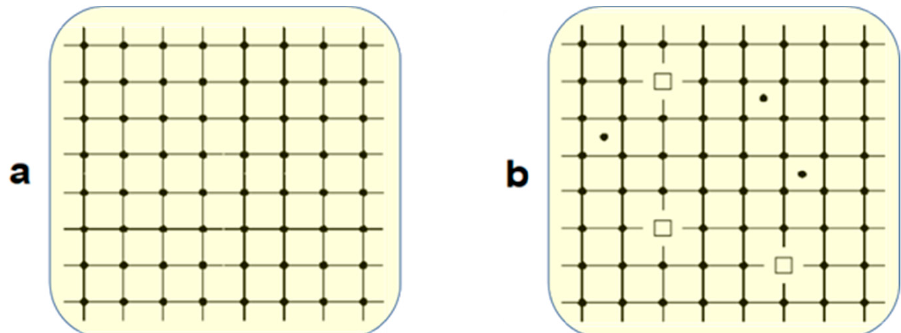
Figure A3: Simplified model of a MOX crystal of ( a ) without and ( b ) with thermal disorder. The thermally disordered crystal features three vacancy-interstitial pairs, resulting in an enlarged free energy 𝛥𝐹 = 𝛥𝐸 − 𝑇𝛥𝑆 .